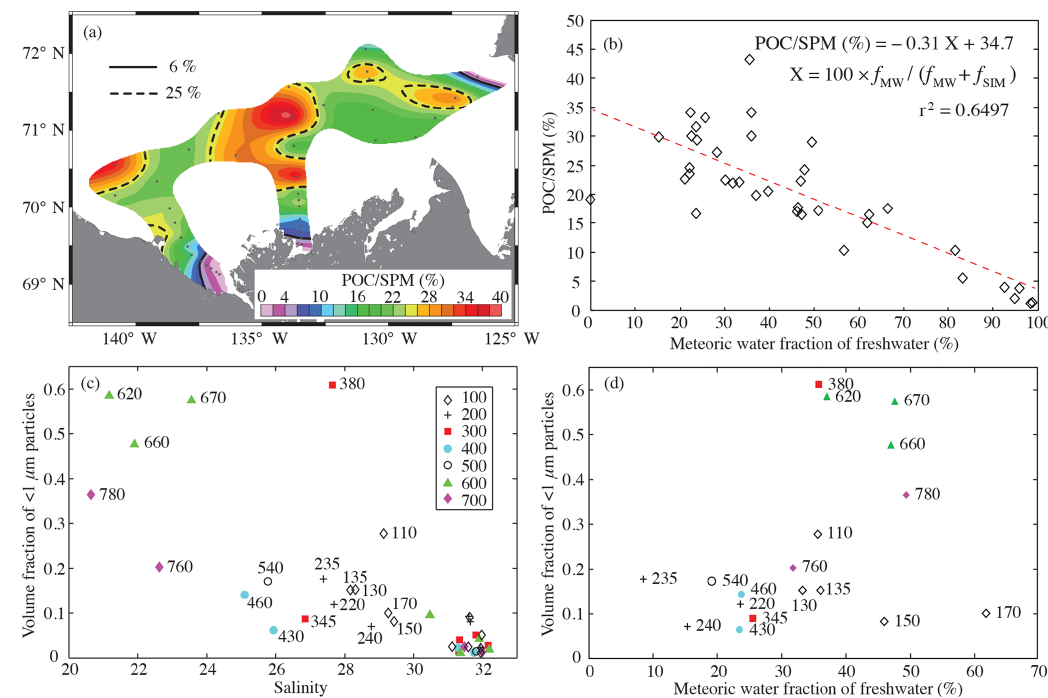
Figure 5. (a) POC-to-SPM ratio for surface samples within the study area, (b) relationship between POC-to-SPM ratio and meteoric water fraction of freshwater in surface waters (see Fig. 2a), and relationship between volume fraction of particles less than 1µm in diameter and (c) salinity, and (d) meteoric water fraction of freshwater. Values in (a) , (b) , and (d) are limited to surface water samples, while data points in (c) with salinities over 30PSU represent subsurface